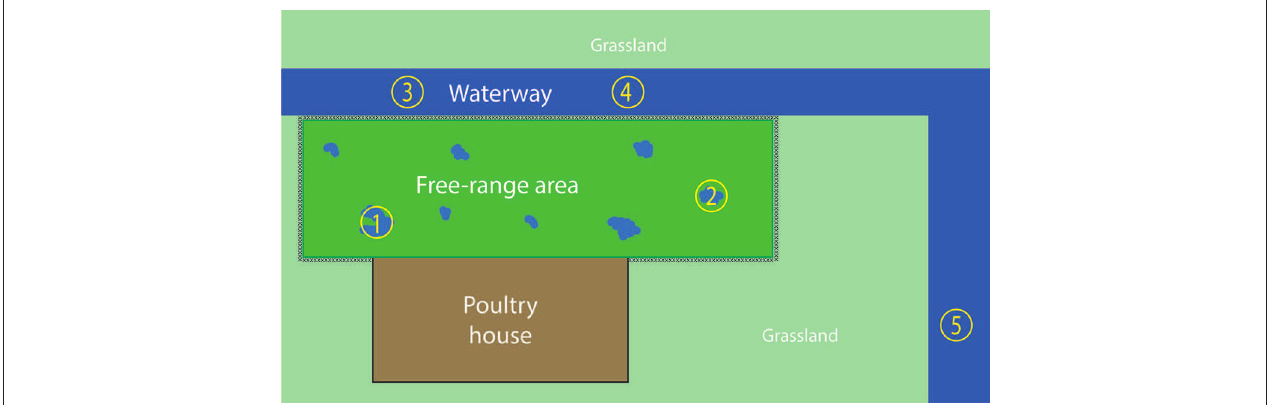
FIGURE 2 | Overview of the water sampling sites. The fenced free-range area is enclosed by the poultry house and waterway. Water samples 1 and 2 were collected from the puddles of water in the free-range area, which were caused by severe rainfall. Water samples 3, 4, and 5 were collected from the waterway. Sampling sites 1–4 were sampled during both farm visits; sampling site 5 was sampled only during the second